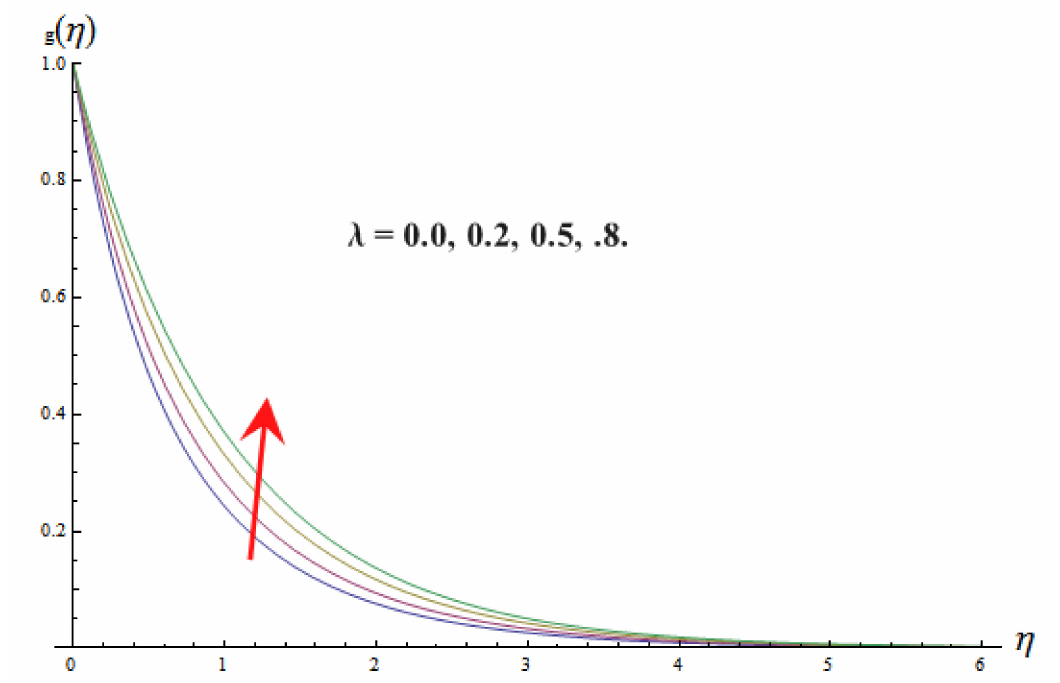
Figure 6. Impact of λ on g ( η ) , keeping λ 1 = 2, Pr = 2, Br = 2, Γ = 0.2, Ec = 0.2, Rd = 2, β 1 = 0.2, Ha = 2, K ∗ =